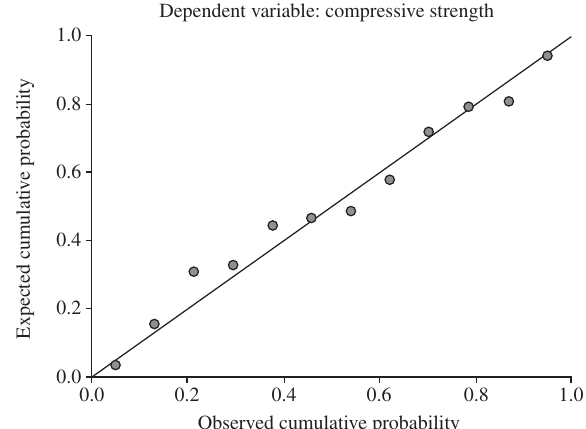
Figure 2. Normal probability plot of the compressive strength.